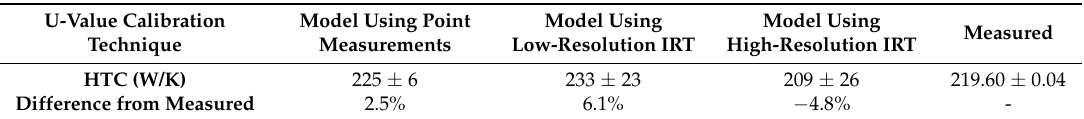
Table 4. Static modelling results using U-values from point measurements, as well as low- and high-resolution IRT.